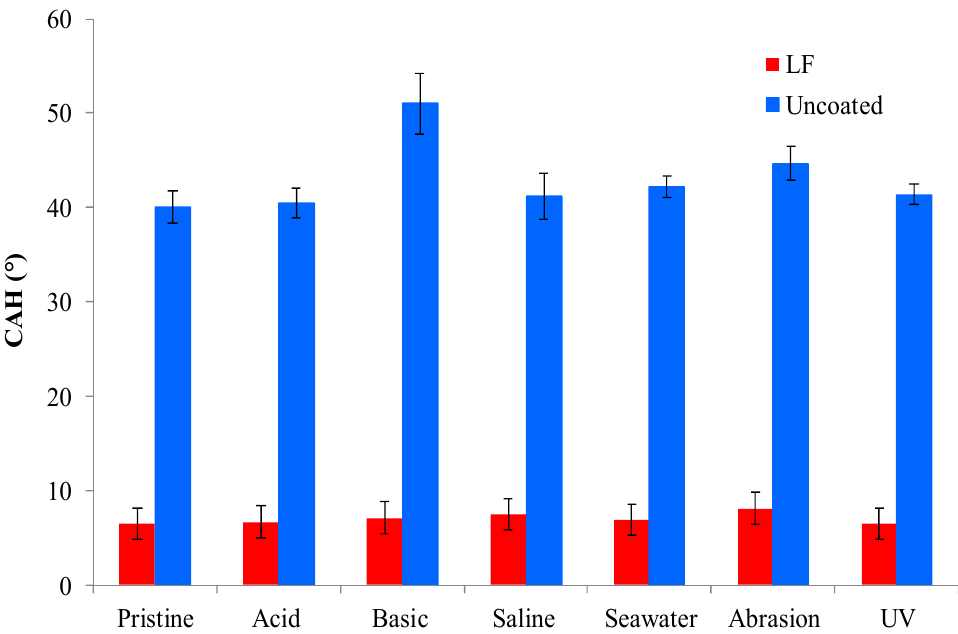
Figure 8. Contact angle hysteresis (WCA) of uncoated (in red) and LF (in blue) samples before (“pristine”) and after ageing tests .